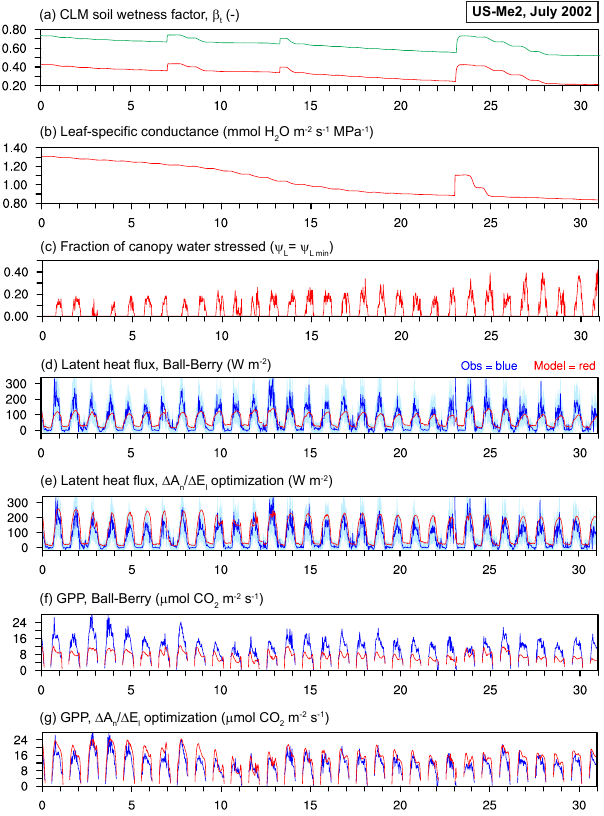
Figure 11. Multi-layer canopy model simulations for US-Me2 for 31 days in July 2002 during a prolonged drought. (a) CLM4.5 soil wetness factor ( β t ). The green line shows β t increased by 0.3, needed to improve latent heat flux and GPP simulations with the CLM Ball–Berry model. (b) Leaf-specific conductance ( k L ) with SPA-WUE optimization. (c) Fraction of canopy that is water stressed with SPA-WUE optimization. (d, e) Latent heat flux sim- ulated with the CLM Ball–Berry model and SPA-WUE optimiza- Figure 10 tion (red) compared with observations (blue). The light blue shading denotes ± 2 standard deviations of the random flux error, σ(ε) . (f, g) Gross primary production simulated with the CLM Ball–Berry model and SPA-WUE optimization (red) compared with observa- tions